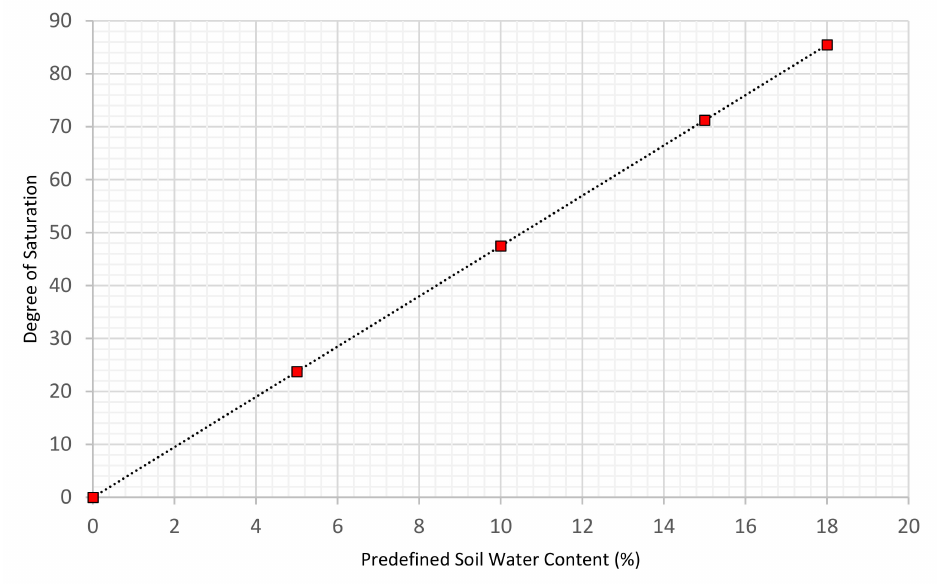
Figure 8. Saturation degree at different water content in compacted